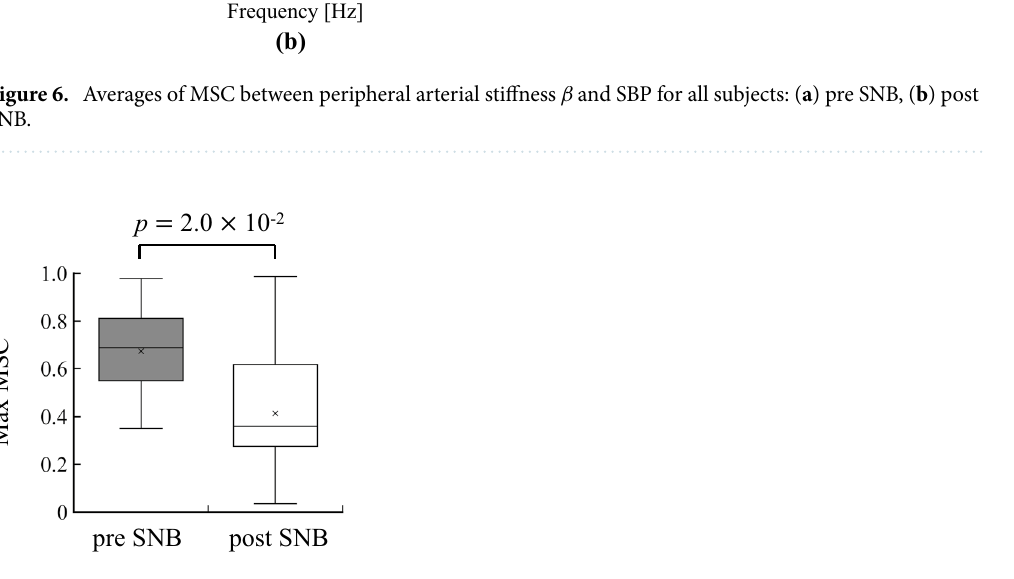
Figure 7. Max MSC at low frequency range LF between peripheral arterial stiffness β and SBP before and after sympathetic nerve block by clipping.